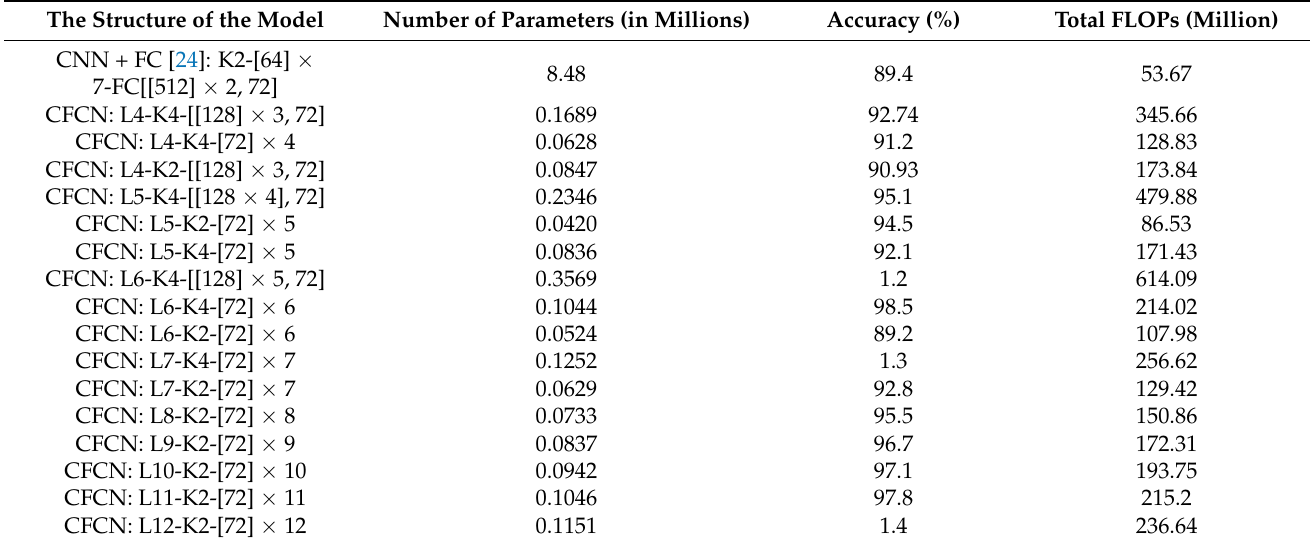
Table 1. Comparison of different model parameters, accuracy, and total floating point operations (FLOPs). The Structure of the